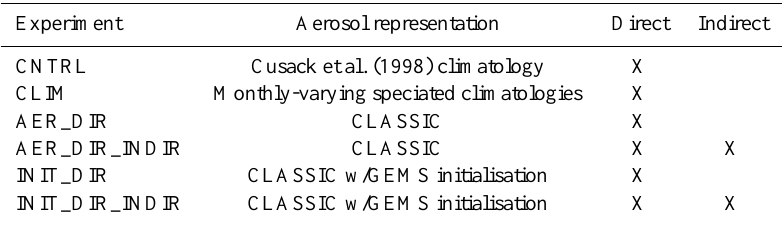
Table 1. List of model experiments and aerosol radiative effects included.